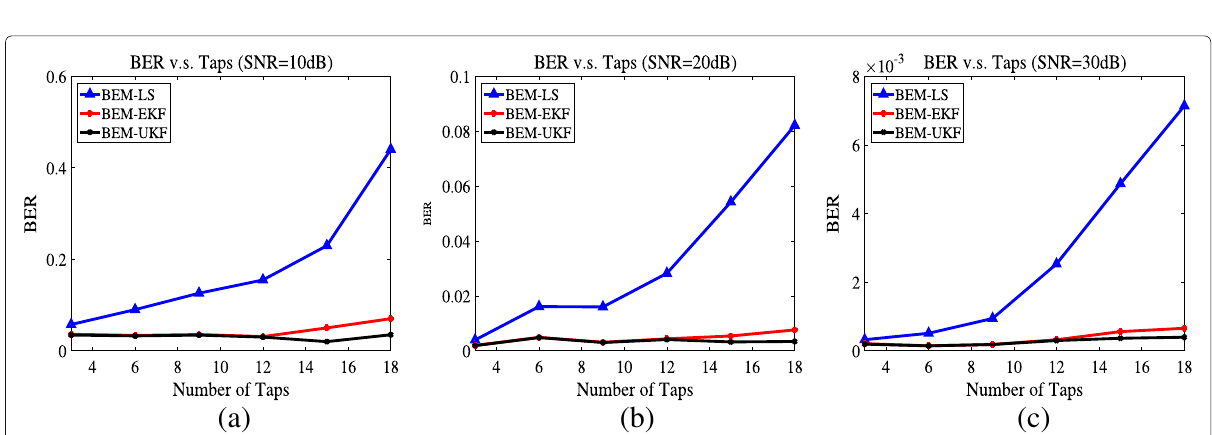
Fig. 7 BER for channel estimation methods in different taps and SNR environments. Under different SNRs, the BER under the BEM-EKF and BEM-UKF channel estimation methods can be stably maintained at a low level with the increase of the number of multi-paths, while the BER has changed a lot under the BEM-LS method